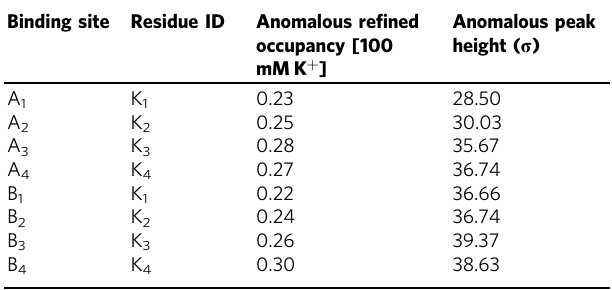
Table 1 Anomalous occupancy re fi nement values of K +